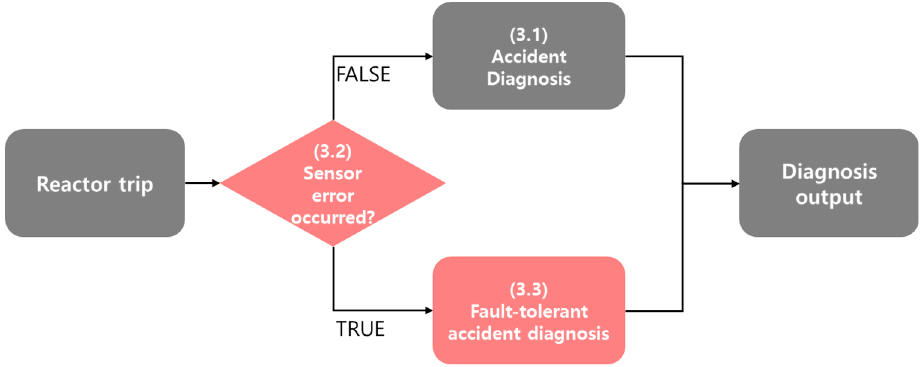
Figure 2. Overall framework for the proposed sensor fault-tolerant accident diagnosis system.